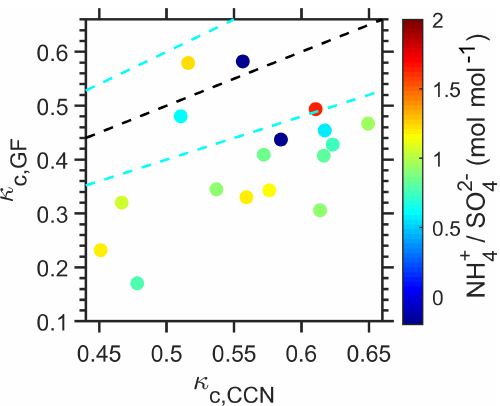
Figure 5. Comparison of κ c , CCN and κ c , GF values for the inter- mediate κ c , CCN category, colored by the measured molar ratios / SO 2 − of NH + . The dashed black line is the 1 : 1 line, while the 4 4 dashed cyan lines represent the ± 20 %